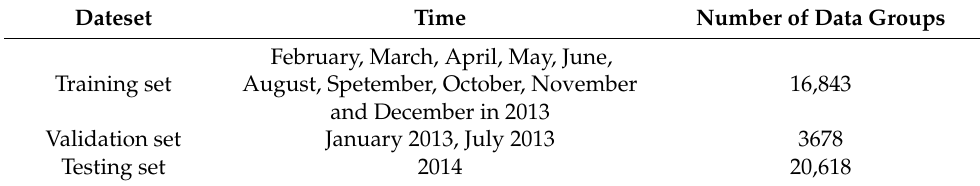
Table 2. The experimental data for DNI forecast.